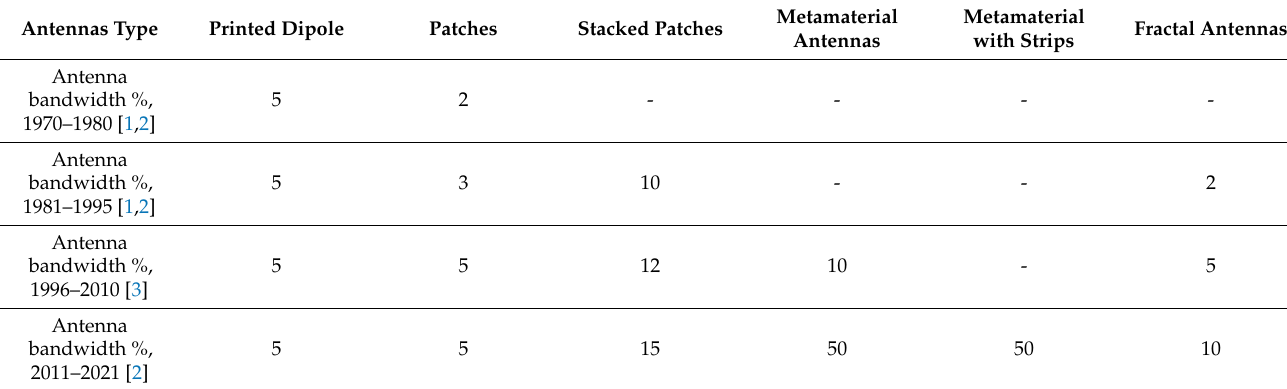
Table 2. Small Antennas Bandwidth Comparison,